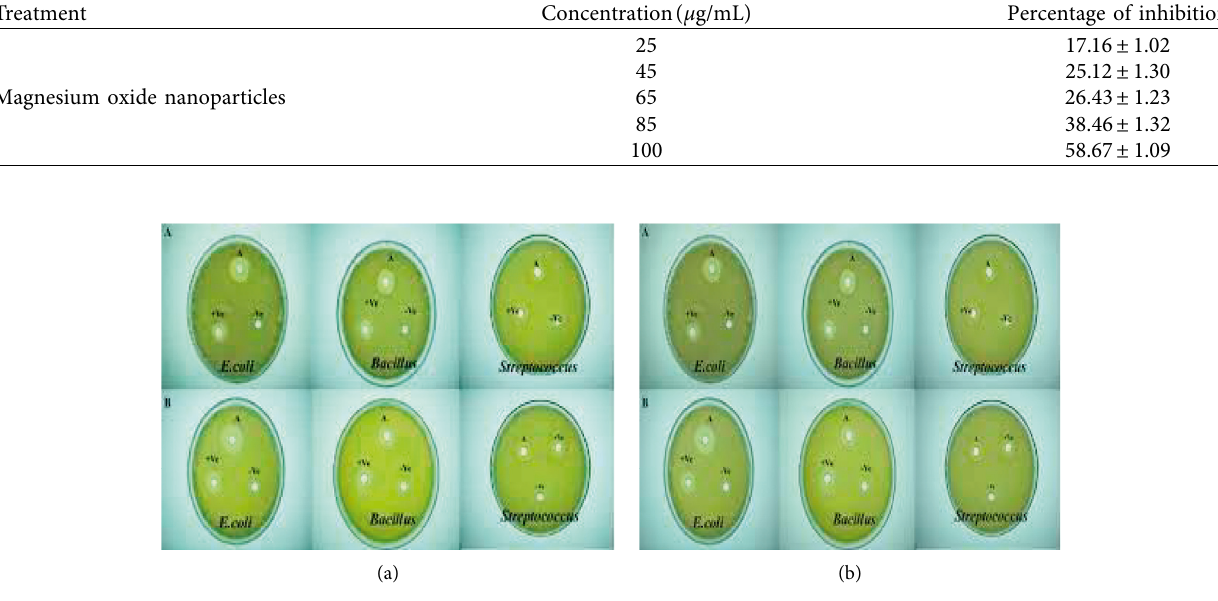
Figure 7: (a, b) Antibacterial activity of biosynthesized and chemosynthesized MgO nanoparticles derived from Datura stramonium (Asaangira), respectively. Table 3: Bacterial activities of chemosynthesized MgO